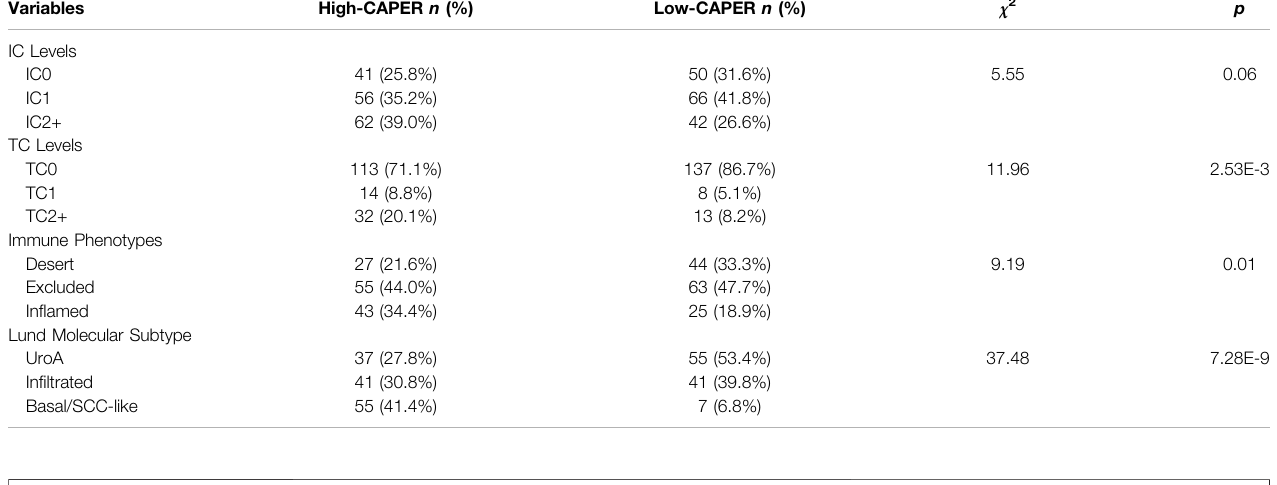
TABLE 6 | Summary of the association between four tumor immunity-related variables and CAPER score in the IMvigor210 cohort. Variables